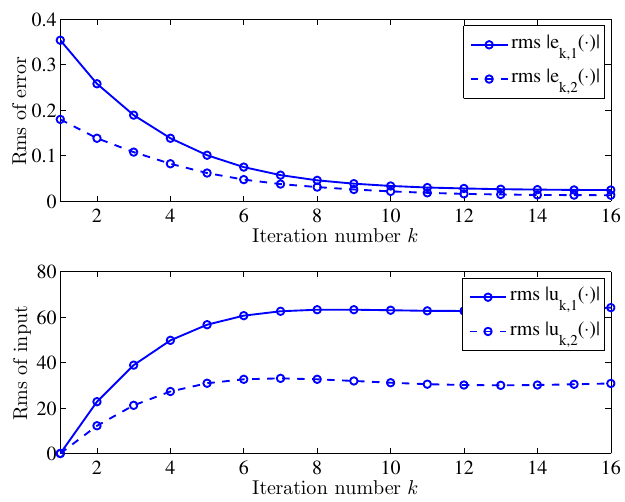
Figure 6. Trajectories of inputs | u k , i ( t ) | and output errors | e k , i ( t ) | using closed-loop iterative learning schemes